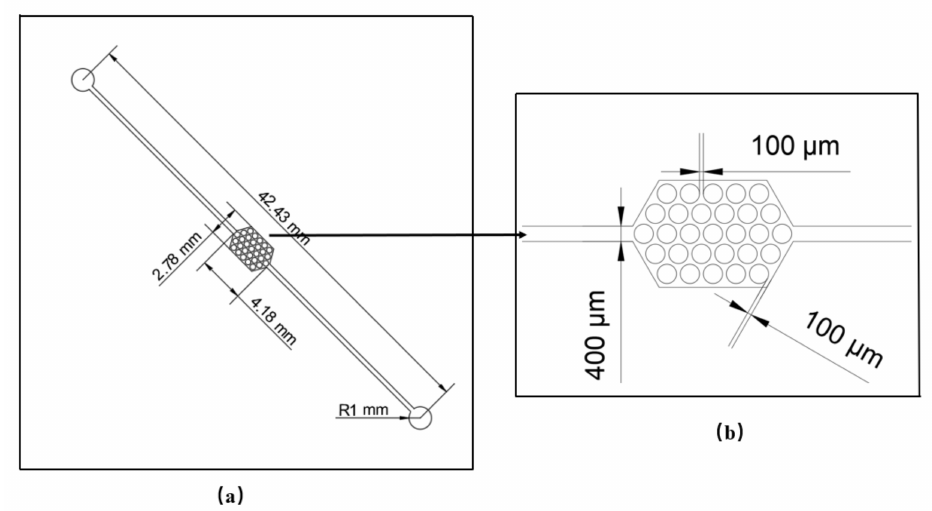
Figure 1. Dimension and structure of the glass microfluidic